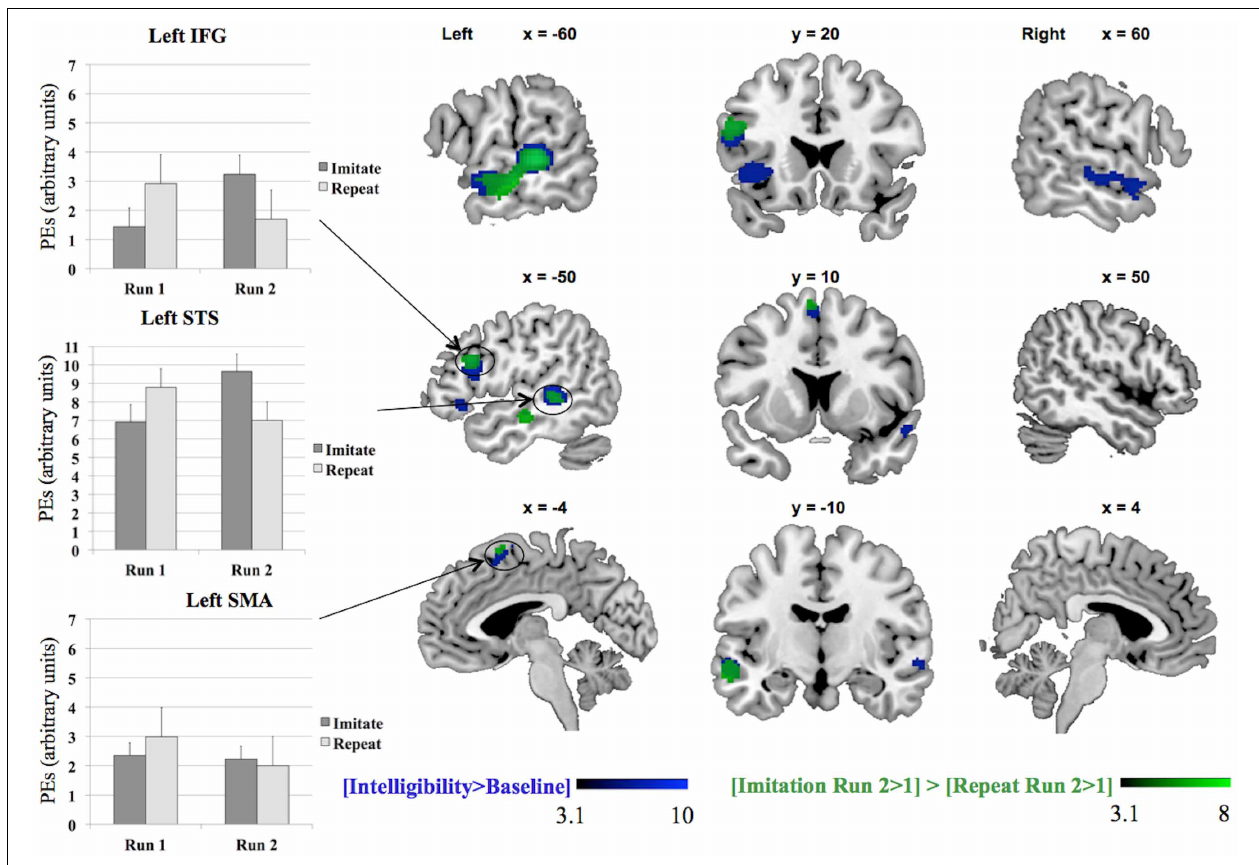
FIGURE 3 | Results for the whole-brain analysis for the contrasts [Intelligibility > Baseline] and [Imitation Run 2 > 1] > [Repeat Run 2 > 1], including plots of the parameter estimates (PEs) per group, IFG = Inferior Frontal Gyrus, SMA = Supplementary Motor Area, STS = Superior Temporal Sulcus. The MarsBaR